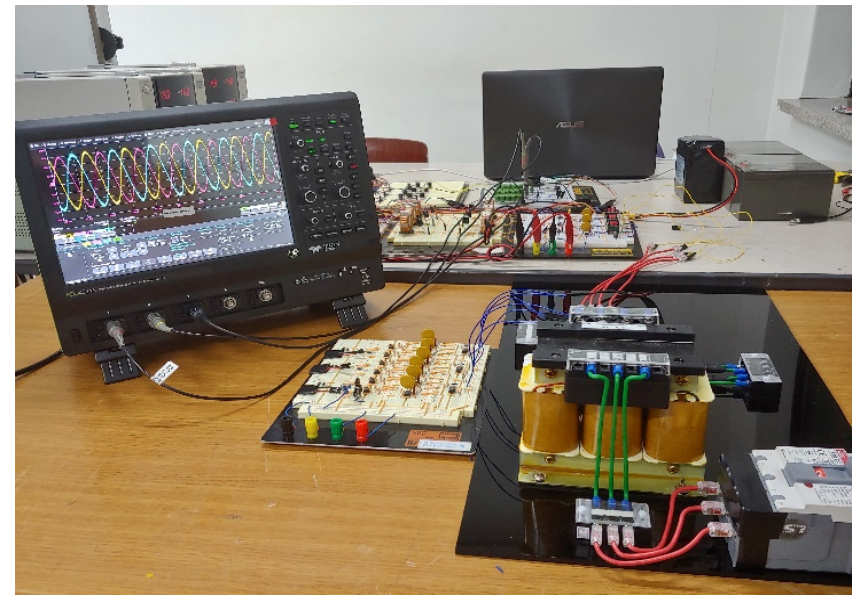
Figure 13. Image of the experimental set up used for validating the effectiveness of the proposed micro DG design.